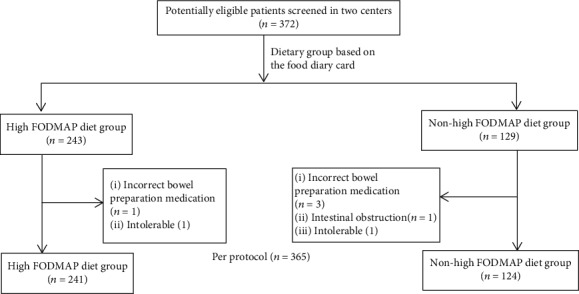
Study flow diagram.